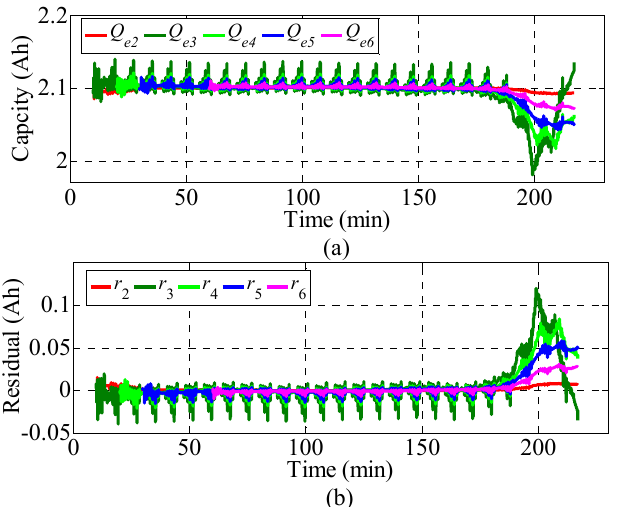
Figure 7. Estimated capacity and capacity residuals: ( a ) capacity; ( b ) r 2 , r 3 , r 4 , r 5 , and r 6 . Residual responses for when a voltage sensor fault occurred at the 50th minute are illustrated in Figure 8. r 1 exceeds the threshold J v in 51.1 min, rises rapidly to 0.245 V, and then fluctuates around 0.25 V until the battery is discharged to 10% SOC. r 3 exceeds the threshold J c in 54.5 min, followed by r 4 , r 5 , r 6 , and r 2 , which is consistent with our expecta- tion that the smaller the SOC change, the higher the sensitivity to a sensor fault. In addi- tion, it can be seen that the OCV residual takes a shorter time to detect the voltage sensor fault than the capacity residuals. Residual responses for a current sensor fault occurring at the 50th minute are shown in Figure 9. r 1 increases slowly after the current sensor fault occurs, exceeds the threshold J v at 72.4 min, and continues to increase slowly. Similar to the occurrence of a voltage sensor fault, among the five capacity residuals, r 3 with a relatively smaller SOC change is still the first to exceed the threshold J c at 62.4 min. However, unlike the voltage sensor fault diagnosis, the capacity residuals take a shorter time to detect the current sensor fault than the OCV residual.